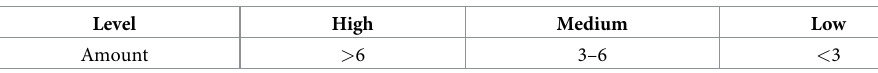
Table 4. The level and amount